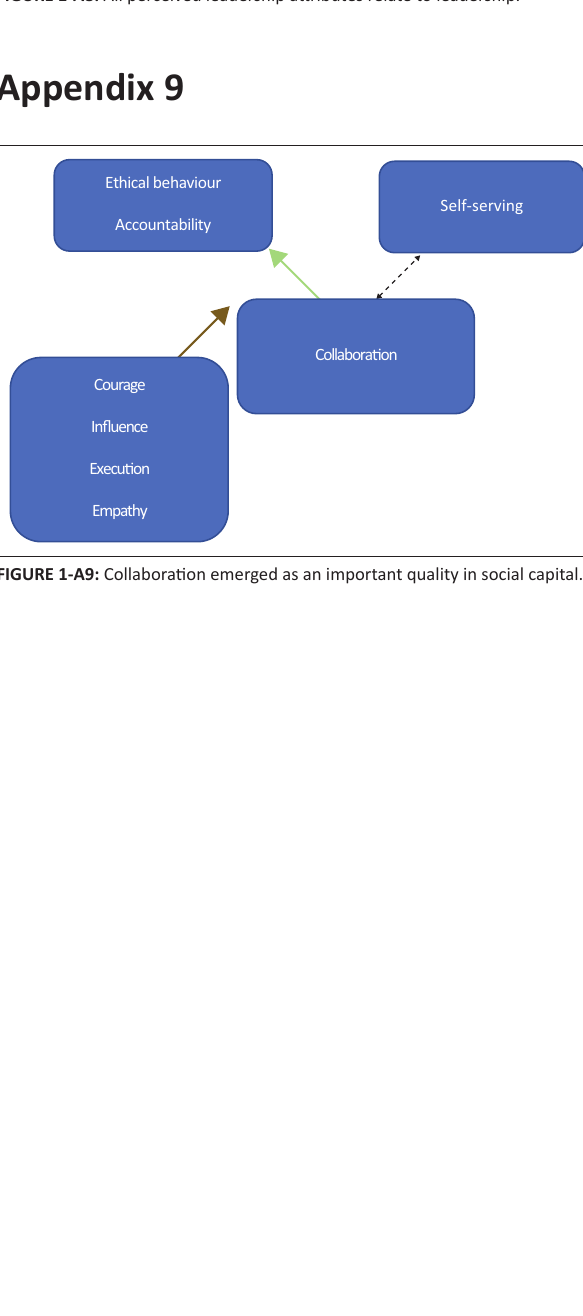
FIGURE 1-A8: All perceived leadership attributes relate to leadership.